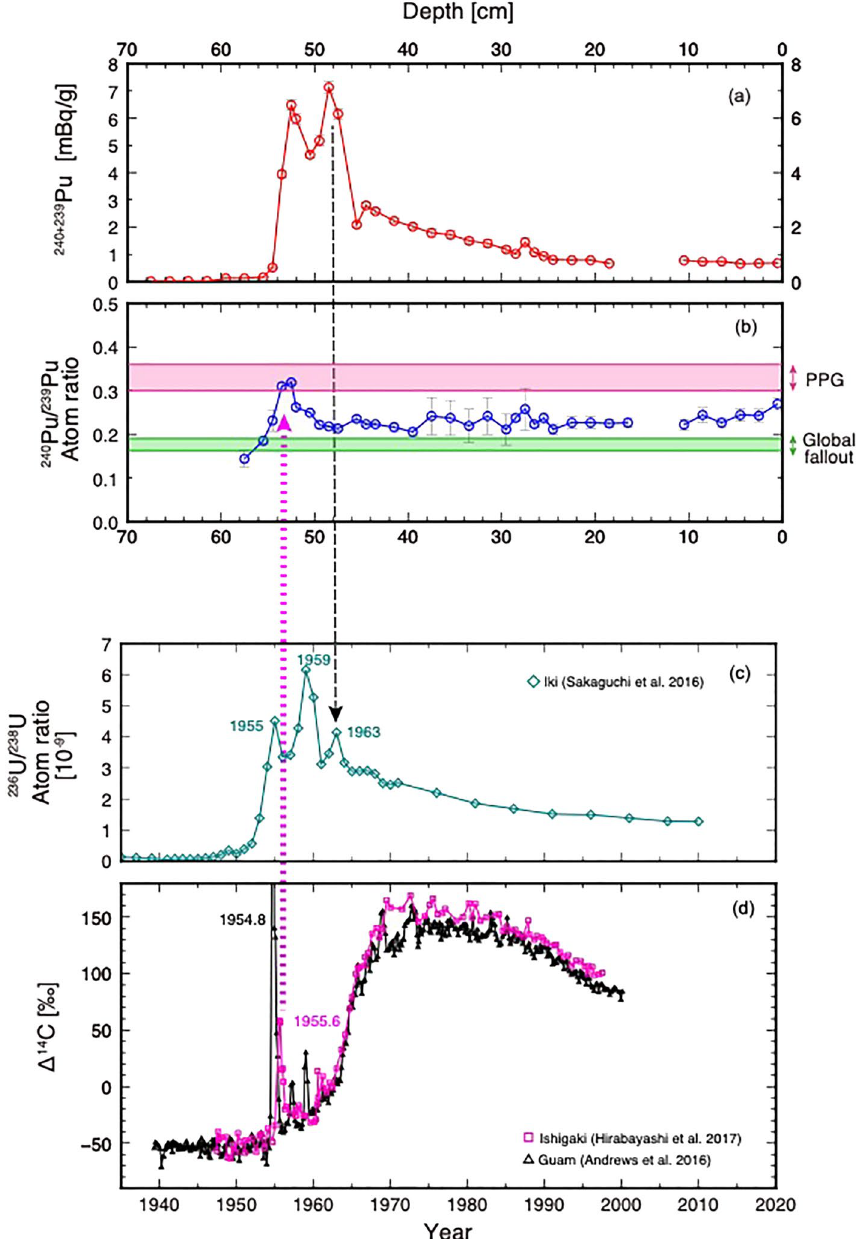
Figure 4. PPG and the Global fallout recorded in the Beppu Bay sediments and coral radiocarbon and uranium measurements. Age model of the sediment taken from Beppu Bay is reconstructed using radioisotopes measurements in corals from Japan. A sharp Δ 14 C peak found in Ishigaki Coral at 1954.8 CE was attributed as the close in fallout signature 13 which is consistent with uranium isotope ratio data obtained from Iki Is 59 . Since Pu isotopes in Beppu Bay sediments clearly show a PPG value at 52.5 cm bsf in the core BMC19, it can be assigned to 1955.6 CE (Red dotted arrows). A linear sedimentation rate is applied to the section between this depth and 24.5 cm bsf (Ev.-1b; 1993.72 CE). The drop in total Pu was attributed to 1963 CE which is consistent with the uranium peak found in corals obtained from Iki (black dotted line), supporting the validity of the Beppu Bay sediment age model. The stratigraphy also verifies that the age of Ev.-1a, found at 46.0 cm bsf as derived from the age model as 1968 CE, is consistent with historical documents of the Hyuganada Earthquake